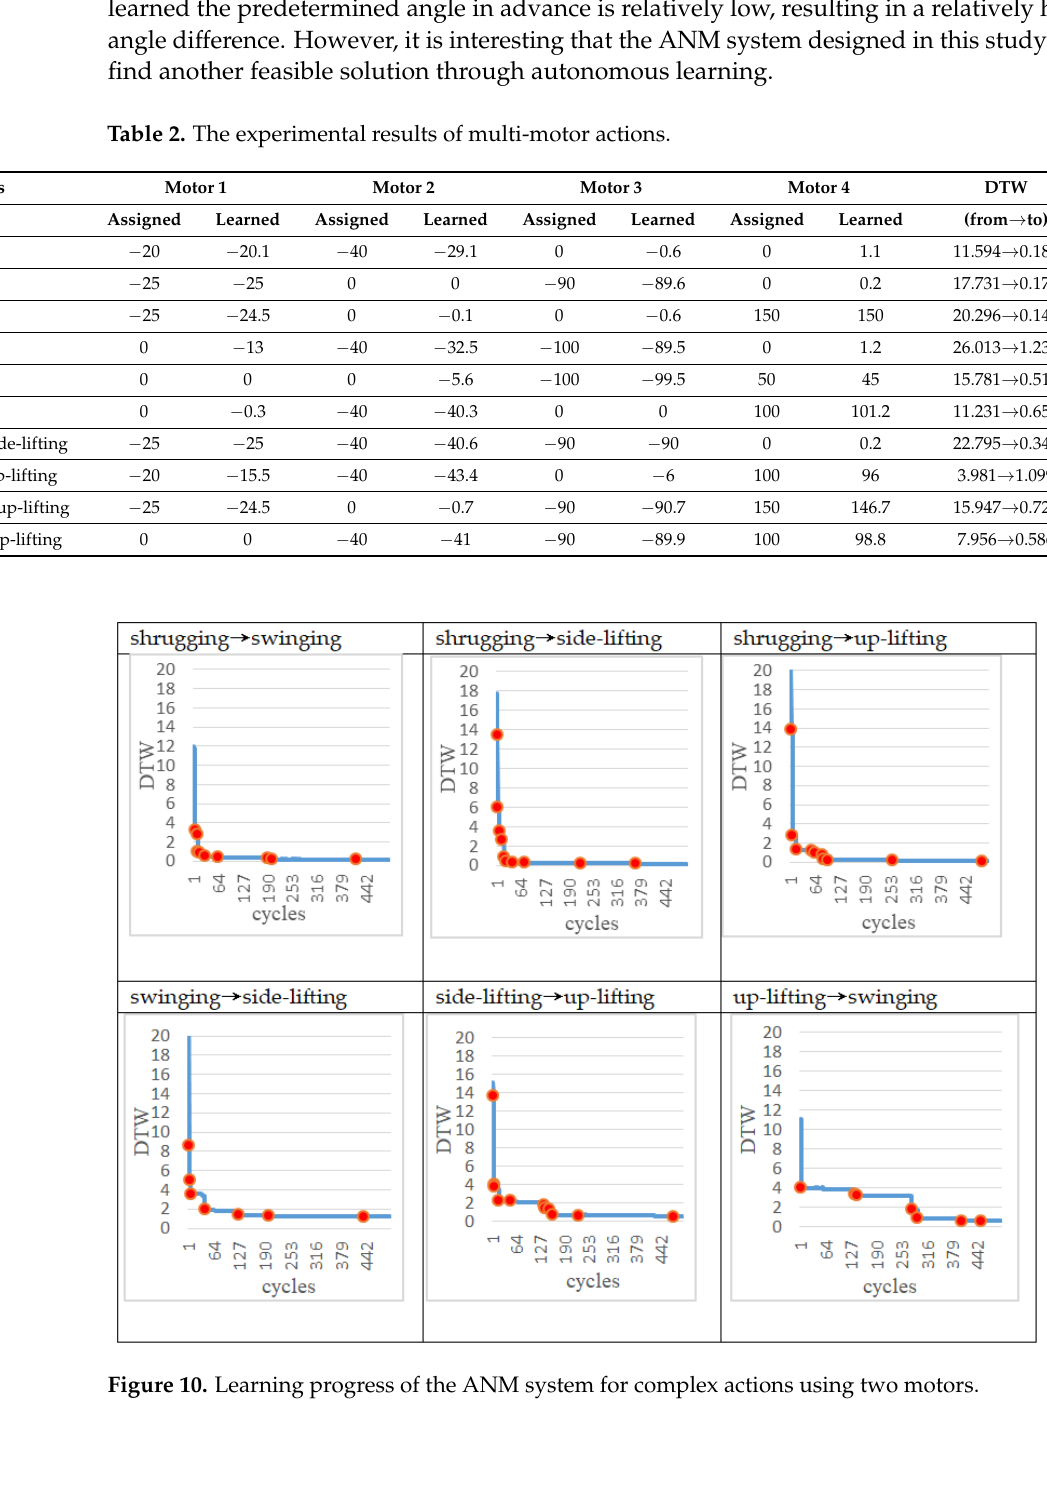
Figure 11. Learning progress of the ANM system for complex actions using three motors. 3.3. Partially Rewarded Actions In the following experiments, instead of giving the entire trajectory, several target points are given to test whether the trajectory generated by the robot arm (controlled by the ANM system) is close to these target points. In other words, we hope that the ANM system can automatically adjust the starting time, sequence, and angle of the four mo- tors to find the closest path to all the target points. From a certain point of view, due to the reduction of the number of learning reference target points, the difficulty for the system to solve these problems can be relatively high. In addition, since the learning target of this experiment is no longer a target trajectory, the DTW evaluation method used in the previous experiments cannot be applied. The evaluation method of this ex- periment is based on the sum of the Euclidean distances between the points closest to the entire trajectory and each target point. There are two methods to select the target points. The first is to randomly take 3, 5, and 7 points, respectively, from the target movement trajectory in the previous experiment as target points. For each of the three target point numbers (3, 5, 7), two experiments were performed. The choice of target point for each experiment was randomly selected from a single motor action or two mo- tor actions. The second method is to arbitrarily select points 3, 5, and 7 as target points within the possible operating range of the trajectory in the previous experiment. In order to understand the problem-solving ability of the ANM system, this experiment increases the number of experiments from two to three for each of these three target point num-